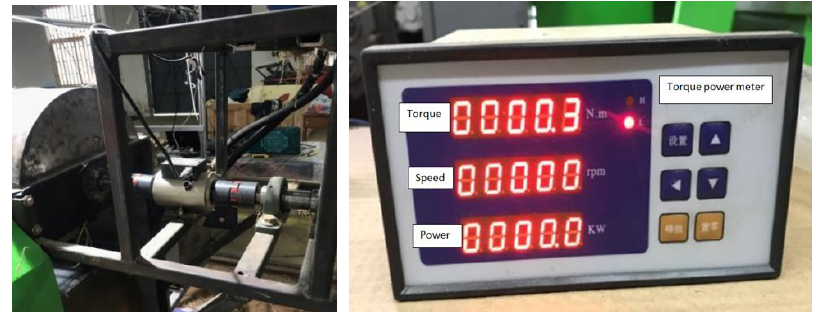
Figure 3. Torque sensor.